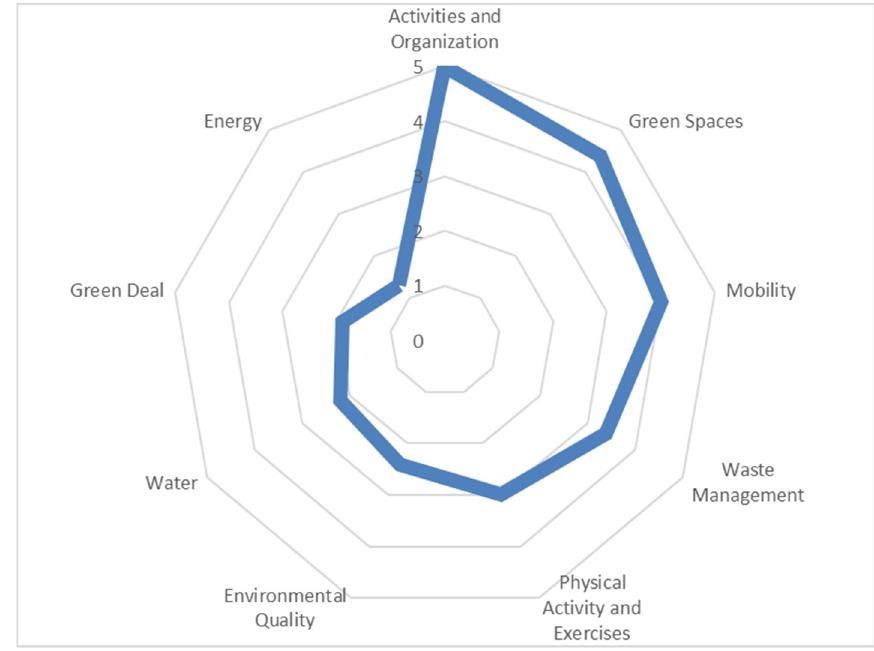
Figure 4. Final SAVING Index from pilot selected residential structure for the elderly.